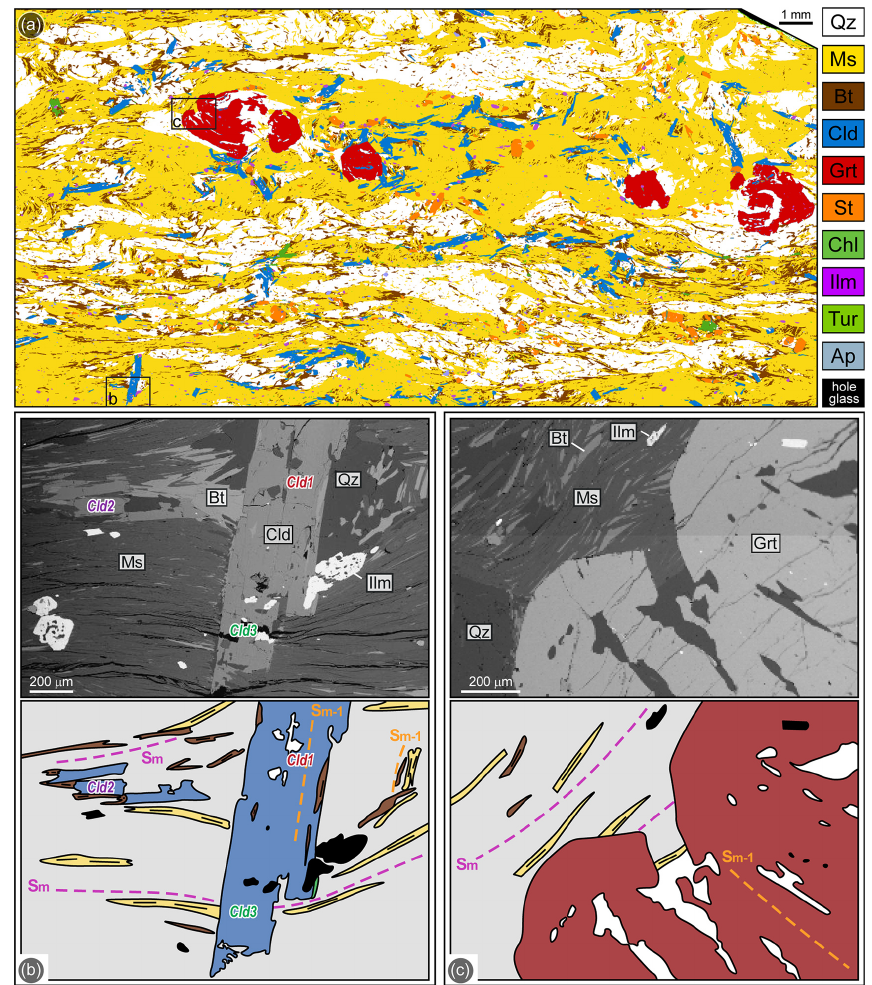
Figure 3. (a) Processed high-resolution multispectral map of sample 19a-4. (b) Chloritoid porphyroblasts growing from pre-kinematic (Cld1) to syn-kinematic (Cld2) and post-kinematic (Cld3) with respect to the Sm. The pre-kinematic generation wrapped by the Sm (Cld1) includes the Sm − 1, the syn-kinematic generation (Cld2) grows along the main foliation Sm and the post-kinematic generation (Cld3) statically overgrows the Sm. The pre- and syn-kinematic generations are coeval with biotite (BSE image and redrawn sketch of the microphotograph). (c) Garnet porphyroblast showing a pre-kinematic core including the Sm − 1 discordant with respect to the Sm, and a post-kinematic rim growing statically on the Sm (BSE image and redrawn sketch of the microphotograph). The grey matrix in the redrawn sketches in panels (b) and (c) mainly consists of